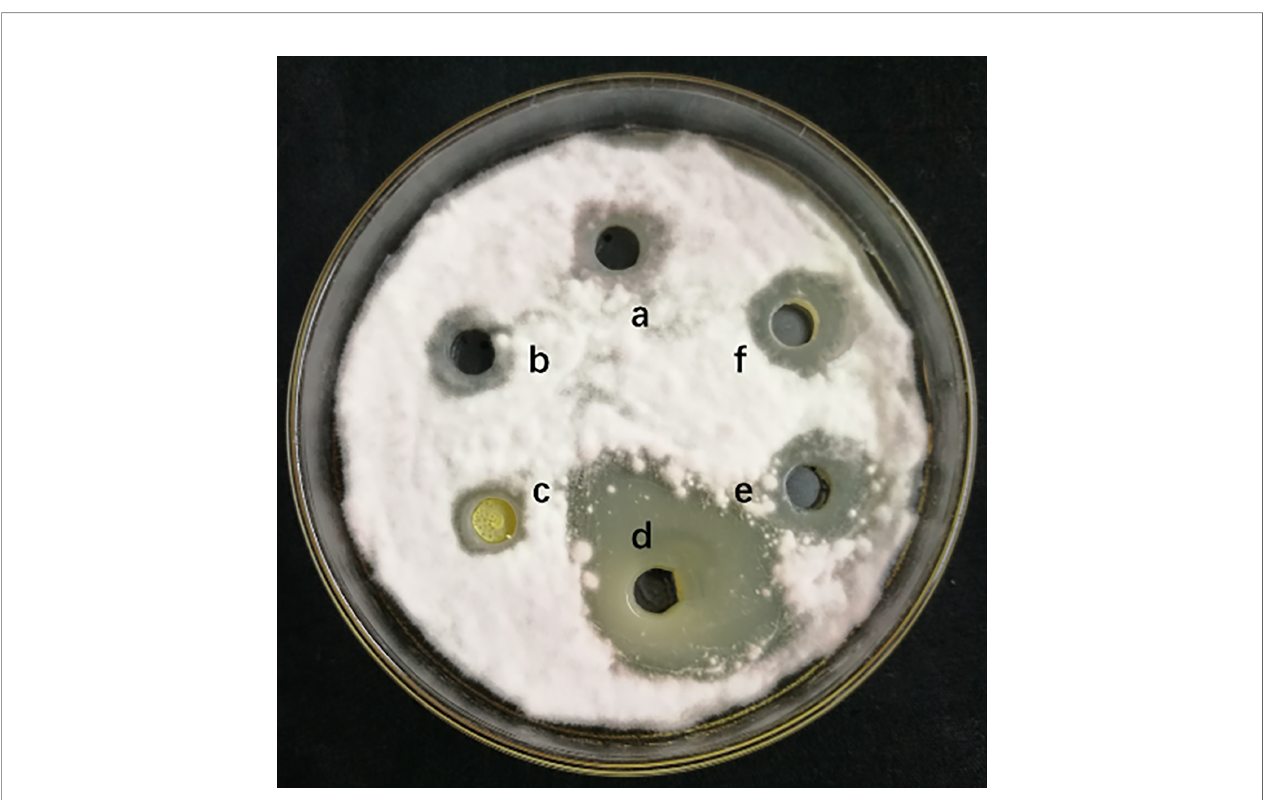
FIGURE 1 | Inhibitory effect of different lipopeptides crude extract on F. solani. a-methanol (negative control), b-Petroleum ether extraction component, c- Ethyl acetate extraction component, d-N-butanol extraction component, e-Water extraction component, f- Methanol crude extract(positively control). A volume of 100 m L of the collected fraction was dropped into the hole on a PDA agar plate with actively growing F. solani . The plates were incubated for 5 days at